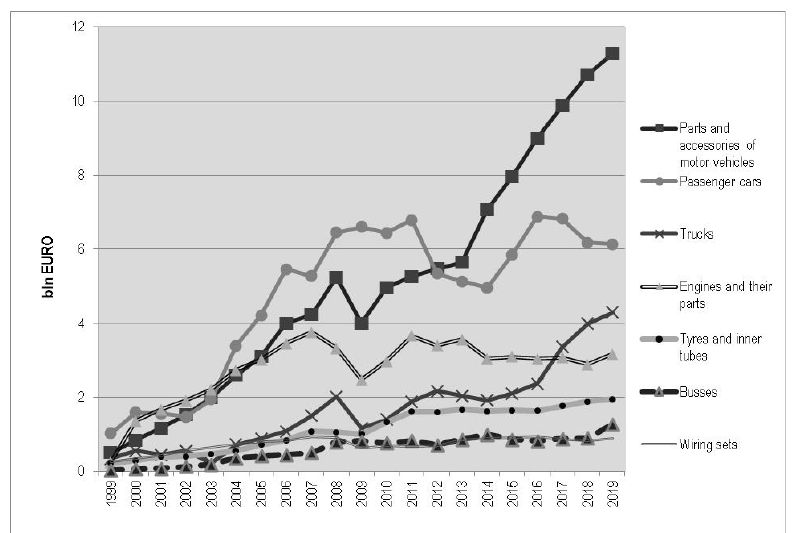
Figure 2. Dynamics of Polish automotive exports 1999–2019. Source: authors’ elaboration based on Eurostat data [54].